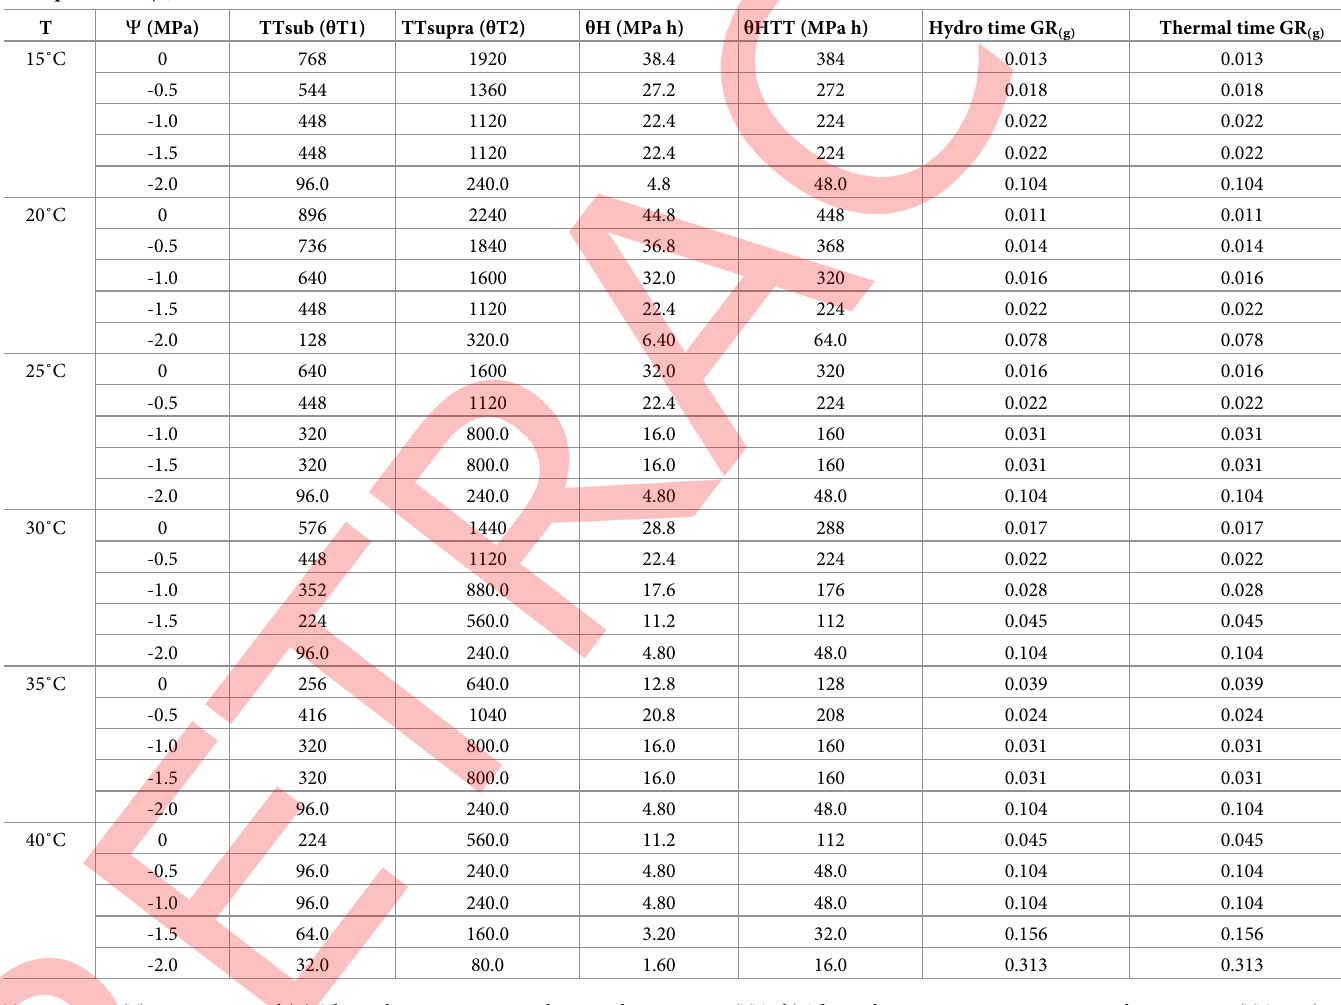
Table 1. The estimated parameters of the hydro and thermal time model to describe Hordeum vulgare L. seed germination under different temperatures ( T s) and water potentials ( ψs